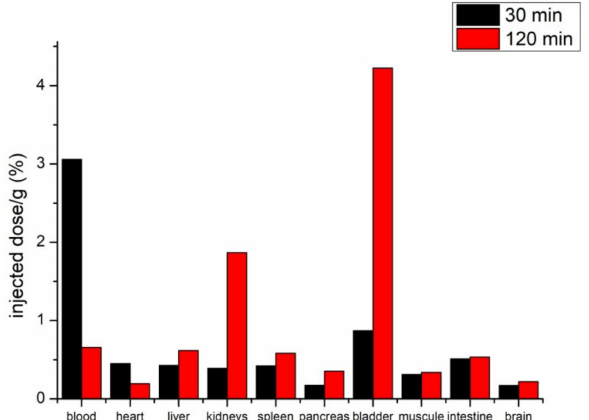
Figure 6. Biodistribution of the VP-VFA-VIDA- 68 Ga complex in intact Wistar rats (200 g), injected with 2–3 MBq and sacrificed after 30 and 120